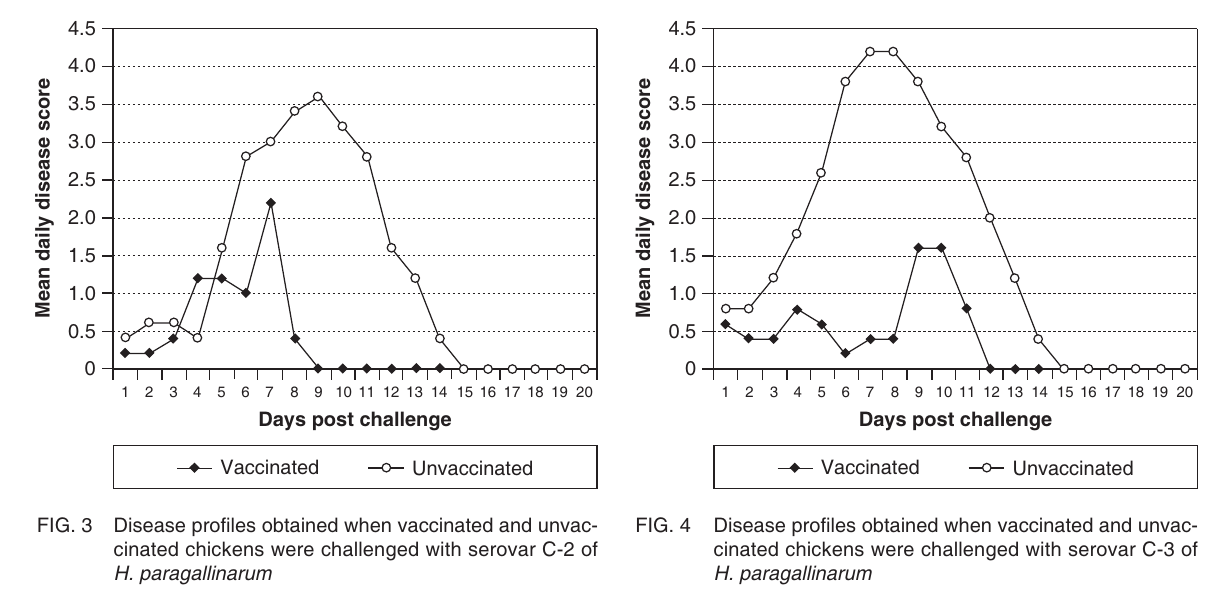
TABLE 1 Mean disease scores, maximum daily disease score, duration of clinical signs and percentage protection obtained in vac- cinated and unvaccinated chickens challenged with the different serovars of H. paragallinarum